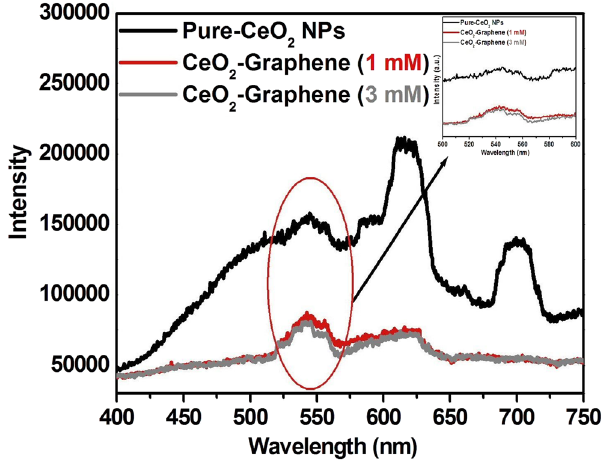
Figure 4. PL spectra of pure-CeO 2 NPs, 1 mM and 3 mM CeO 2 -Graphene